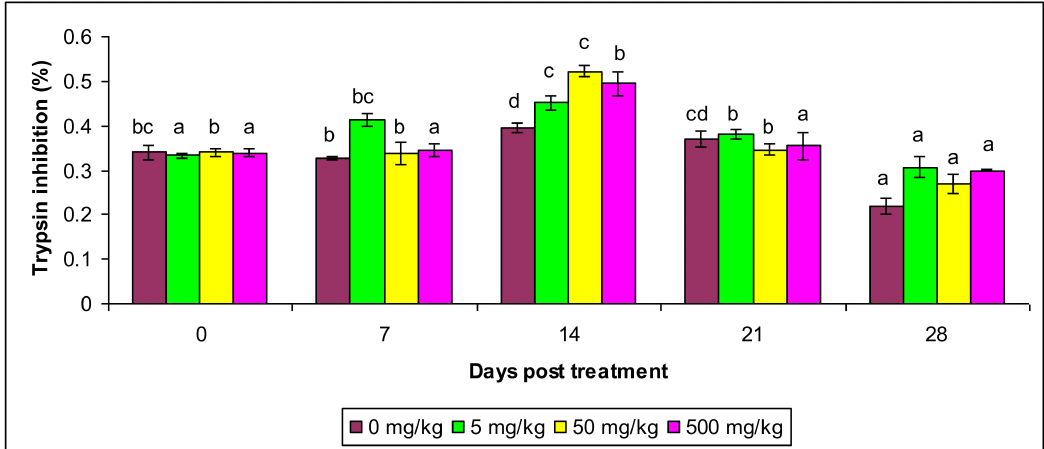
Figure 5. Serum antiprotease activity under different treatments administered with various levels of C. aerea extract in L. rohita during post treatment days (values are mean ± SE). Mean values with different superscript within a column for a parameter are significantly different ( p <